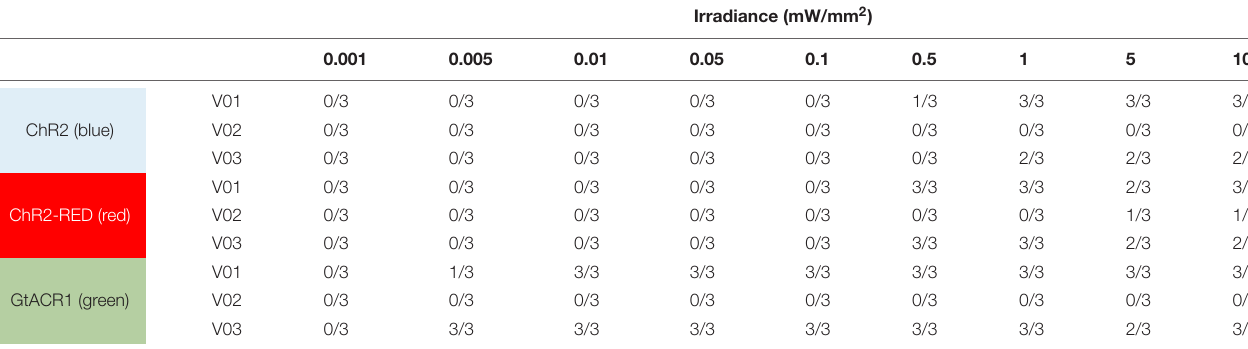
FIGURE 6 | Defibrillation with very weak light stimuli succeeds in GtACR1-expressing models despite persistent sub-epicardial conduction. (A,B) Activation maps for no light control (A) , and E e = 0.005 mW/mm 2 stimulus applied to GtACR1-expressing model (B) . Dashed lines (top) show cut plane locations for cross-sections (bottom). Arrows indicate wavefront propagation directions. Double lines show sites of conduction block. Asterisks highlight conduction block region on endocardium. (C) V m (t) traces for nodes spanning from LA endocardium to epicardium (golden dot) in the GtACR1 condition are provided. Illumination (green shaded region) begins at t = 0 ms and lasts 1000 ms. TABLE 2 | Defibrillation success rates for ChR2, ChR2-RED, or GtACR1-expressing ventricular models for different irradiance